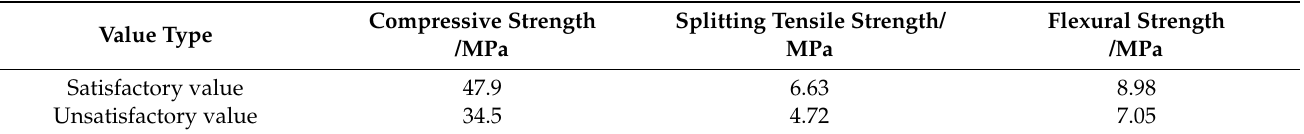
Table 7. Satisfaction and unsatisfactory values of each